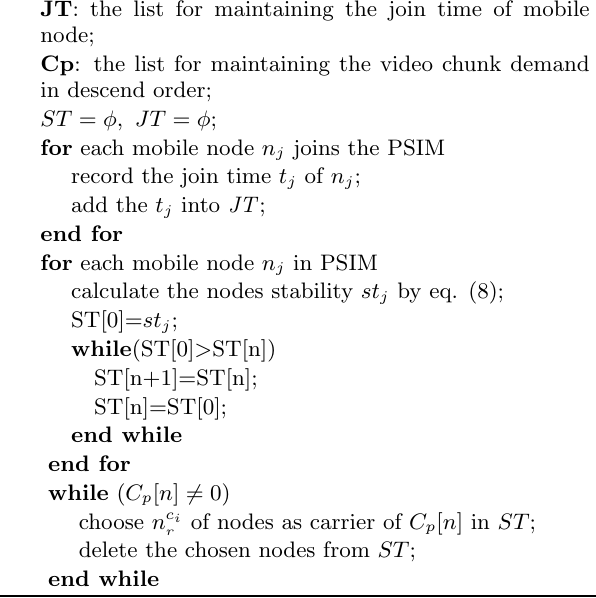
Algorithm 2 : Cooperative Carrier Selection